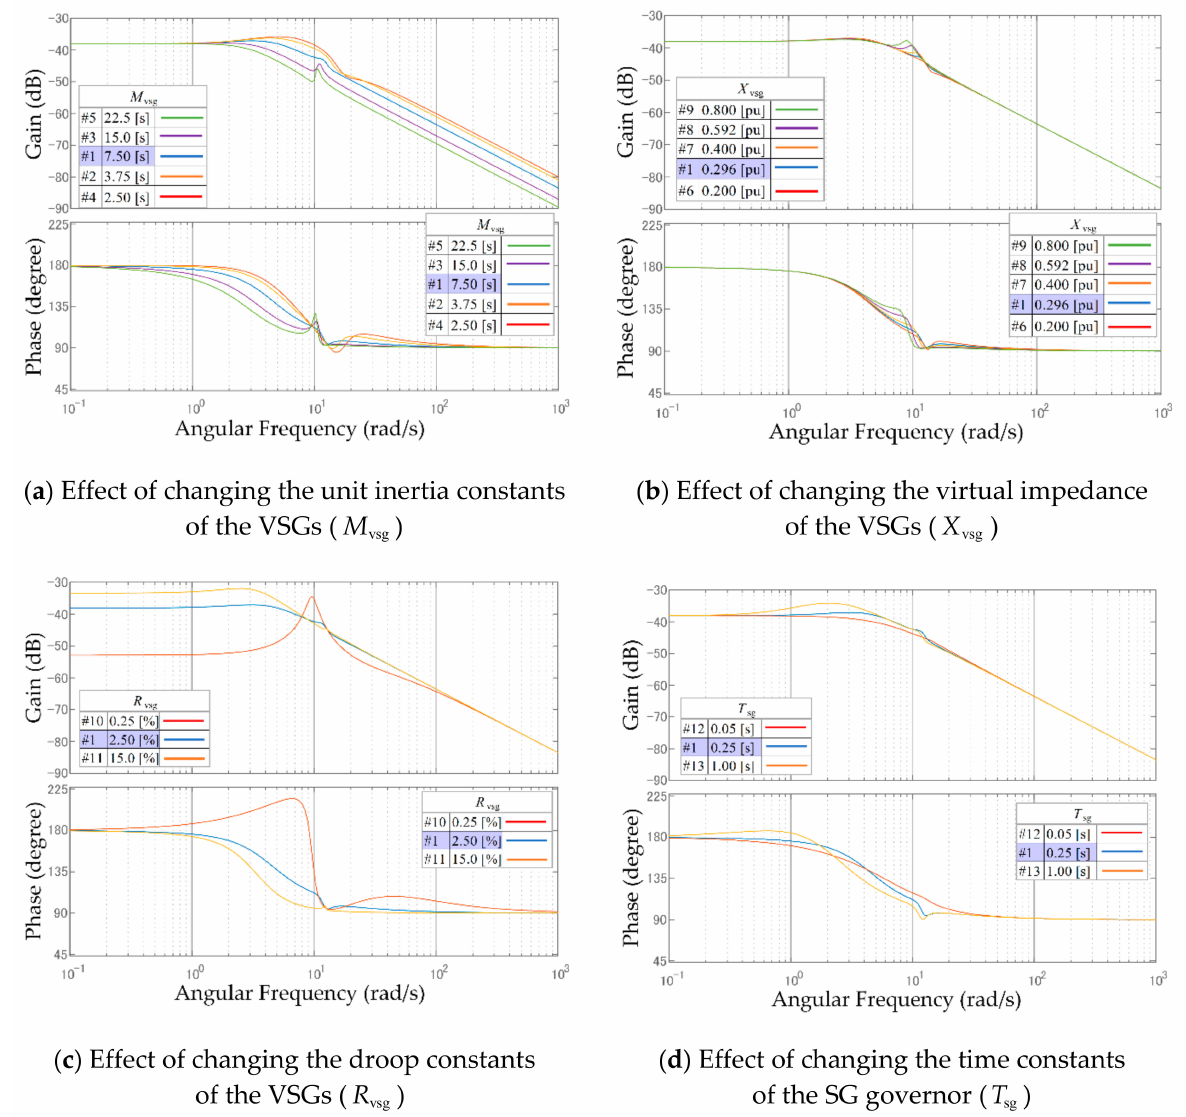
Figure 12. Frequency characteristics from an additional load power change ( ∆ P ) on the deviation of the center of inertial frequency ( ∆ F c ) of the